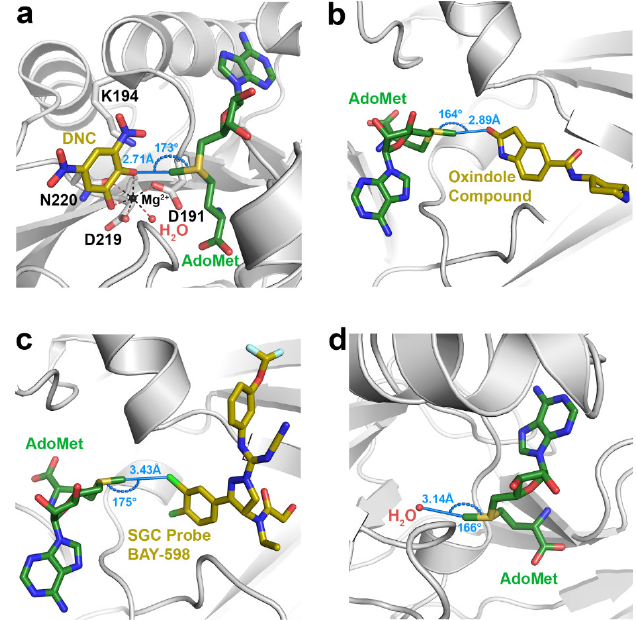
Figure 1. Representative examples of methyl tetrel bonding in crystal structures of AdoMet-dependent methyltransferases. AdoMet and small molecule inhibitors are depicted with green and yellow carbon atoms, respectively. Methyl tetrel bonding distances R(C···X) and angles θ(S–C···X) are denoted in blue. ( a ) COMT bound to AdoMet, DNC, and an Mg 2+ ion (PDB accession code 5LSA). Key active site residues are illustrated, including the Mg 2+ -coordinating residues and the catalytic Lys194. ( b ) The SET domain KMT SMYD3 bound to AdoMet and an oxindole-containing inhibitor (5CCL). ( c ) SMYD2/AdoMet/SGC Probe BAY-598 ternary complex (5ARG). ( d ) SET domain KMT G9A bound to AdoMet and Inhibitor 13 (not shown) (5VSC). A water molecule in the substrate lysine binding channel of the enzyme engages in a methyl C ··· O tetrel bond with